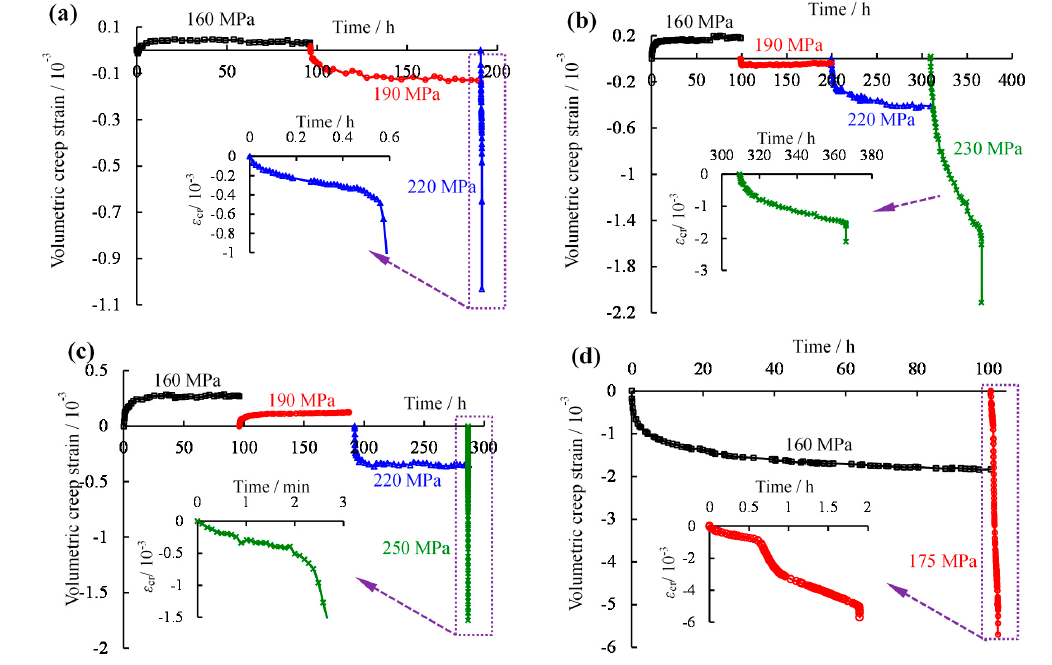
Figure 6. Lateral creep strain ‐ time curves under same stress condition at different temperatures ( σ 3 = 25 MPa): ( a ) σ 1 − σ 3 = 160 MPa; ( b ) σ 1 − σ 3 = 190 MPa; ( c ) σ 1 − σ 3 = 220 MPa; ( d ) Relationship between lateral creep and temperature.